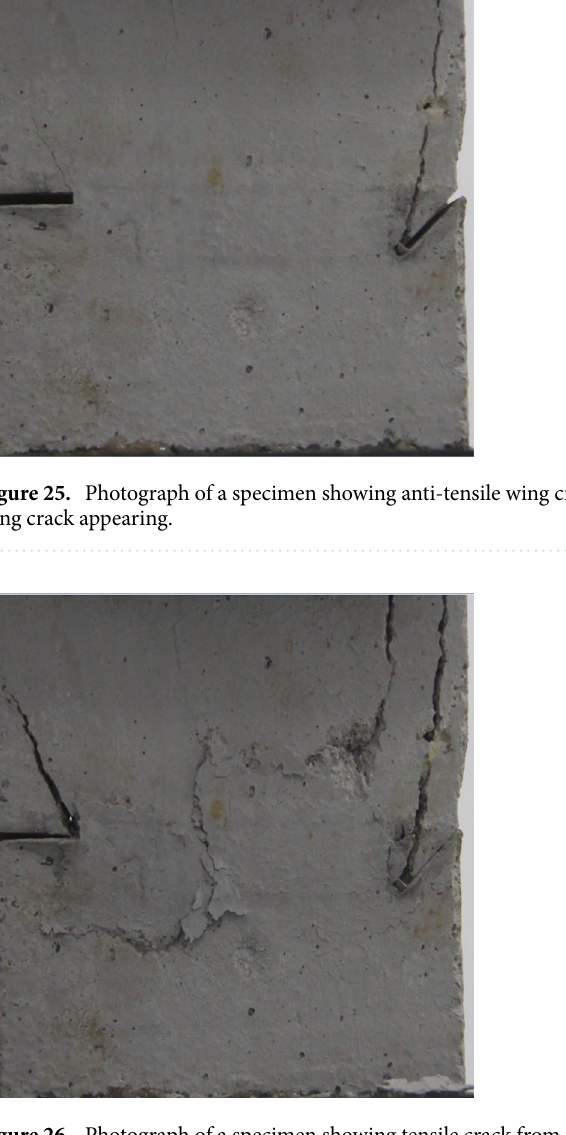
Figure 26. Photograph of a specimen showing tensile crack from the top surface caused by compression and transverse shear crack